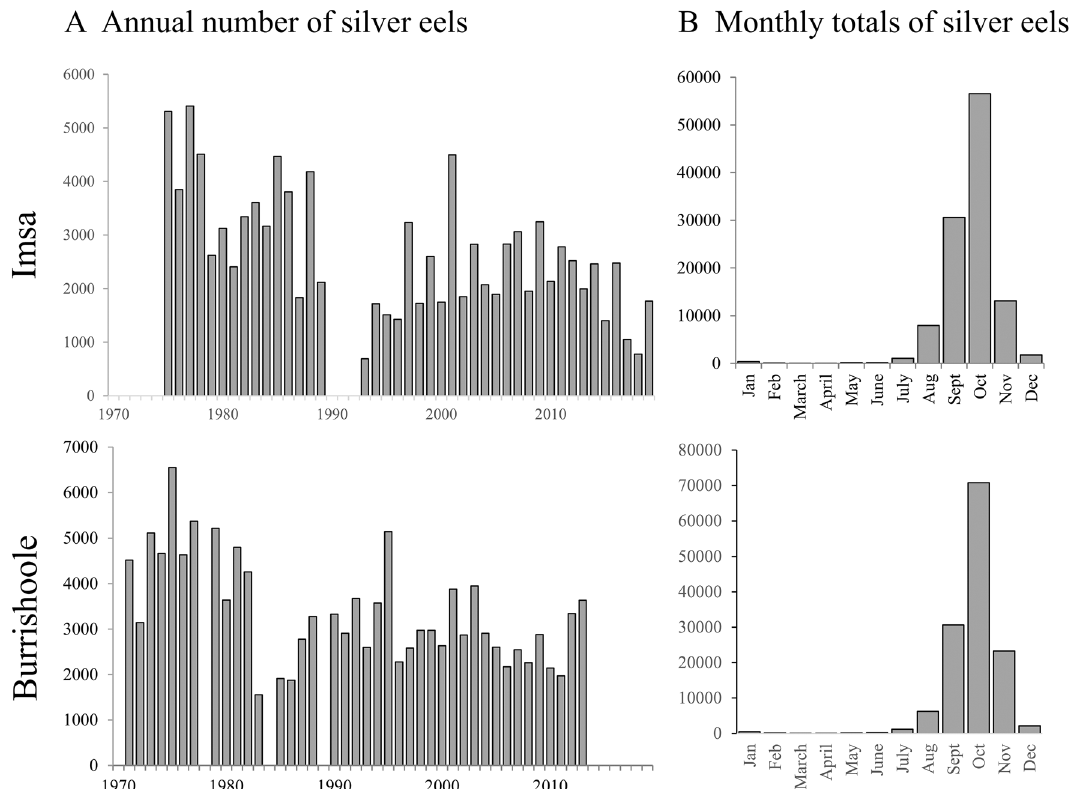
Figure 2. Description of silver European eel ( Anguilla anguilla ) populations migrating on the Imsa and Burrishoole rivers: ( A ) Annual number of silver eels caught and ( B ) total catch per month over the study period. Mann–Kendall trend tests were performed on annual catches (Mann–Kendall tau = − 0.33 and p -value = 0.01 on the Imsa River; Mann–Kendall tau = − 0.35 and p -value = 0.01 on the Burrishoole